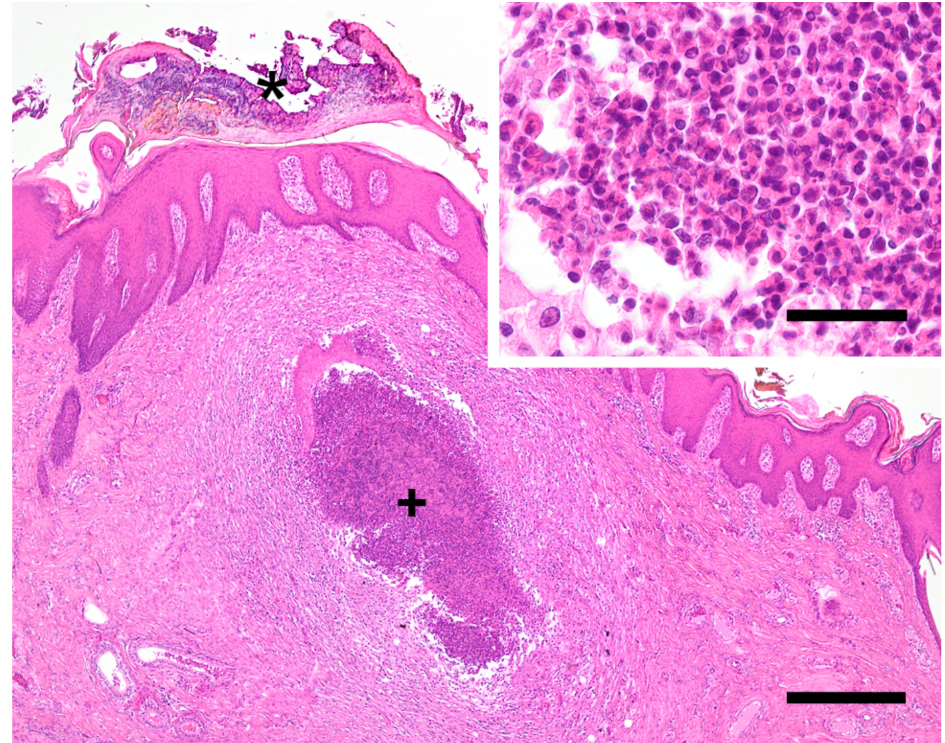
Figure 3. Skin of the pinna. Epidermis is covered by thick serocellular crusts consisting of keratin, neutrophils and detached epithelial cells indicated by the asterisk and intradermal abscess indicated by the cross (H&E, bar = 400 µ m). Inset indicates higher magnification of pus in the superficial dermis (H&E, bar = 40 µ